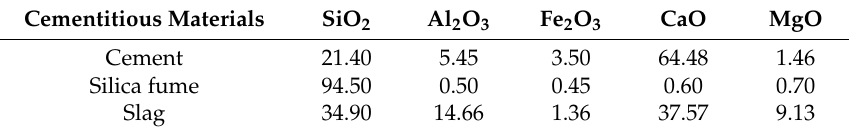
Table 1. Chemical compositions of cement, silica fume, and slag in percentage. Cementitious